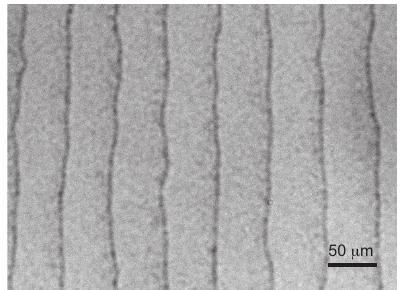
Figure 16. Geometrical elementary dislocations decorated by nanoparticles observed in transmission microscopy. The sample thickness is 20 µ m and the concentration of nanoparticles is 0.225 wt % (from Ref. [30]).